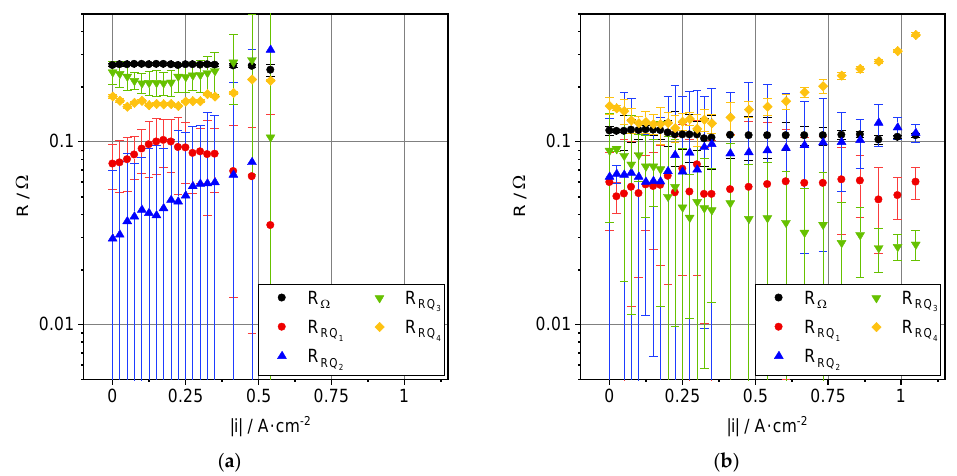
Figure 7. Resistances with respect to current density for a ratio of CO 2 :CO of 80:20 at 6 l·h -1 at ( a ) 700 °C and ( b ) 900 °C.